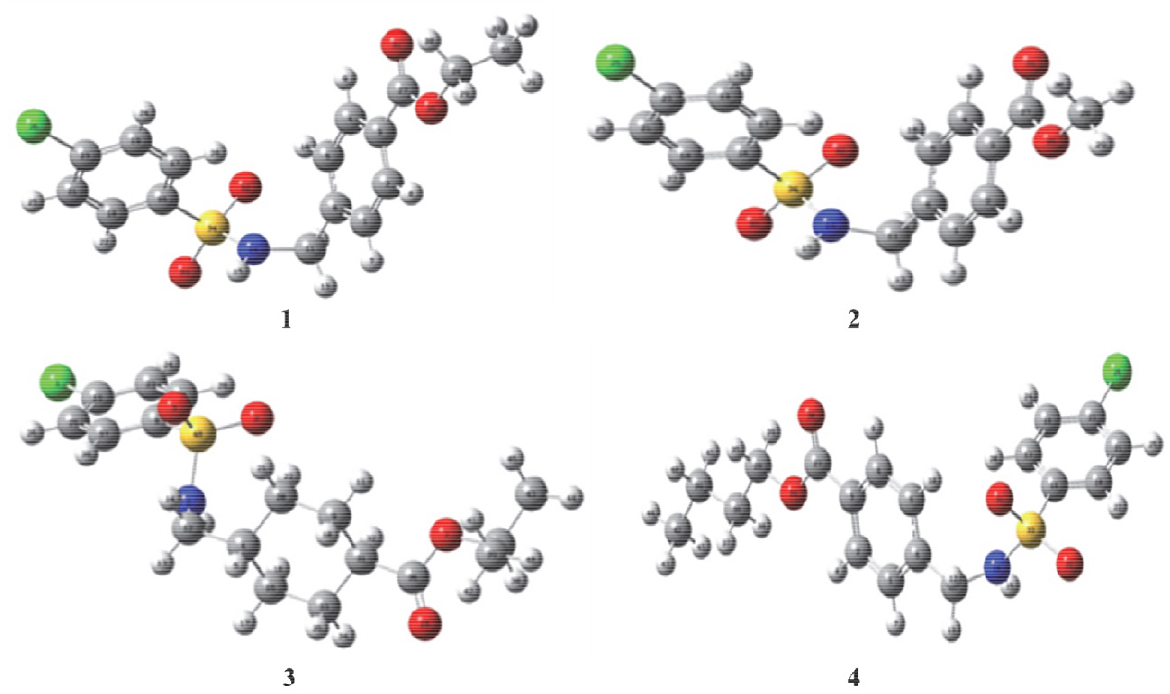
Figure 9. Optimized structures of synthesized